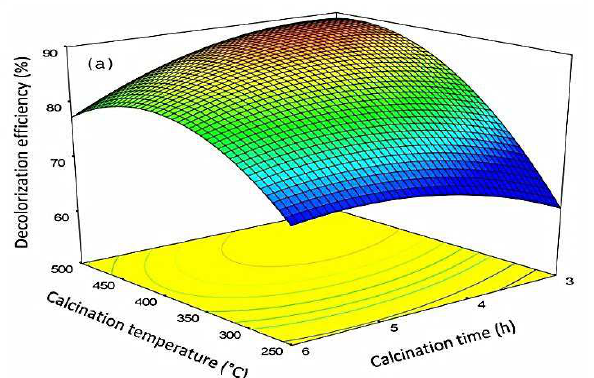
Figure 2. a) Response surface plot of photocatalytic methylene blue (MB) removal (%) as the function of calcination temperature and calcination time